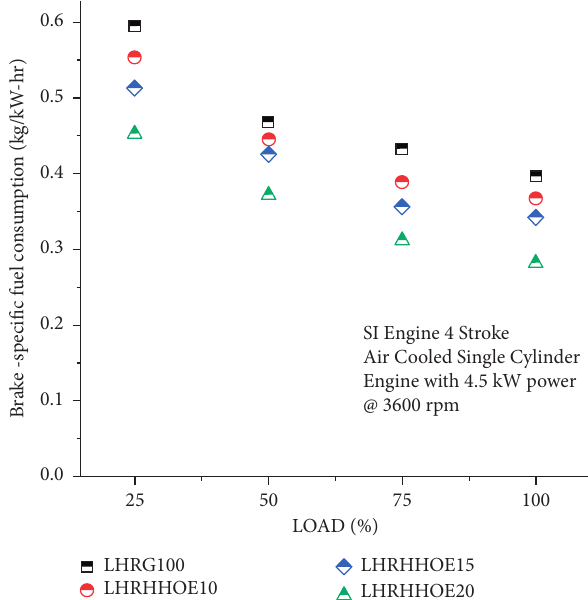
Figure 3: Study on fuel consumption on the nanocoated ethanol- gasoline